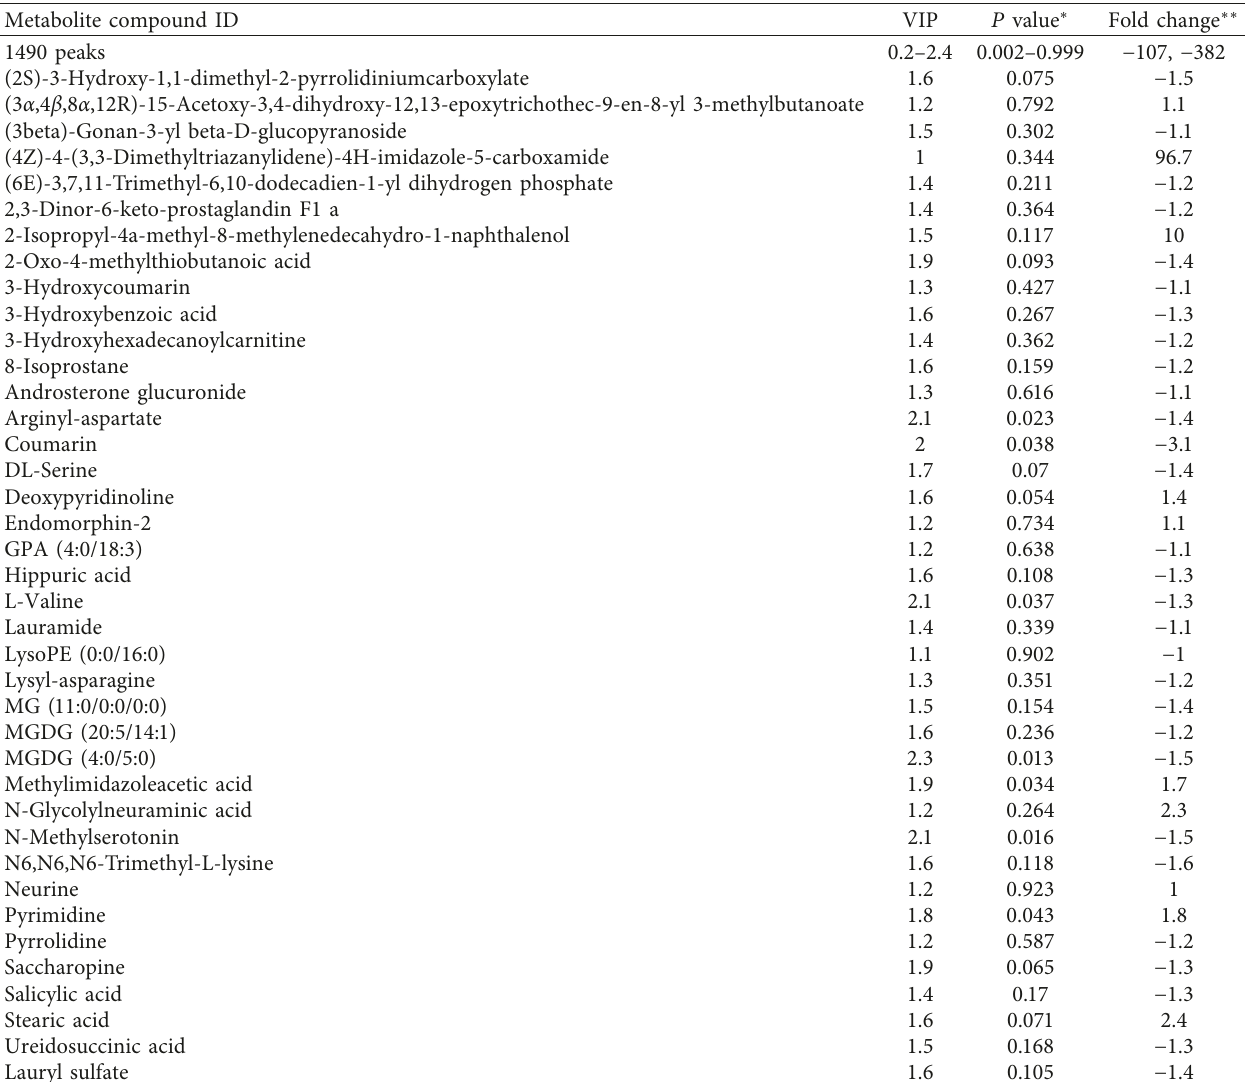
Table 3: Summary of salivary metabolites differentially expressed in poorly controlled vs. well-controlled type II diabetes. Metabolite compound